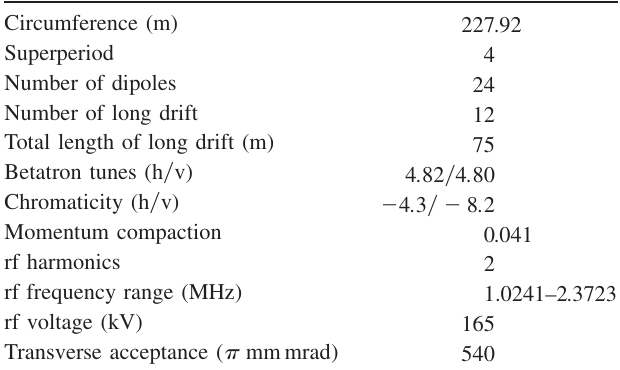
TABLE VIII. Main parameters of CSNS